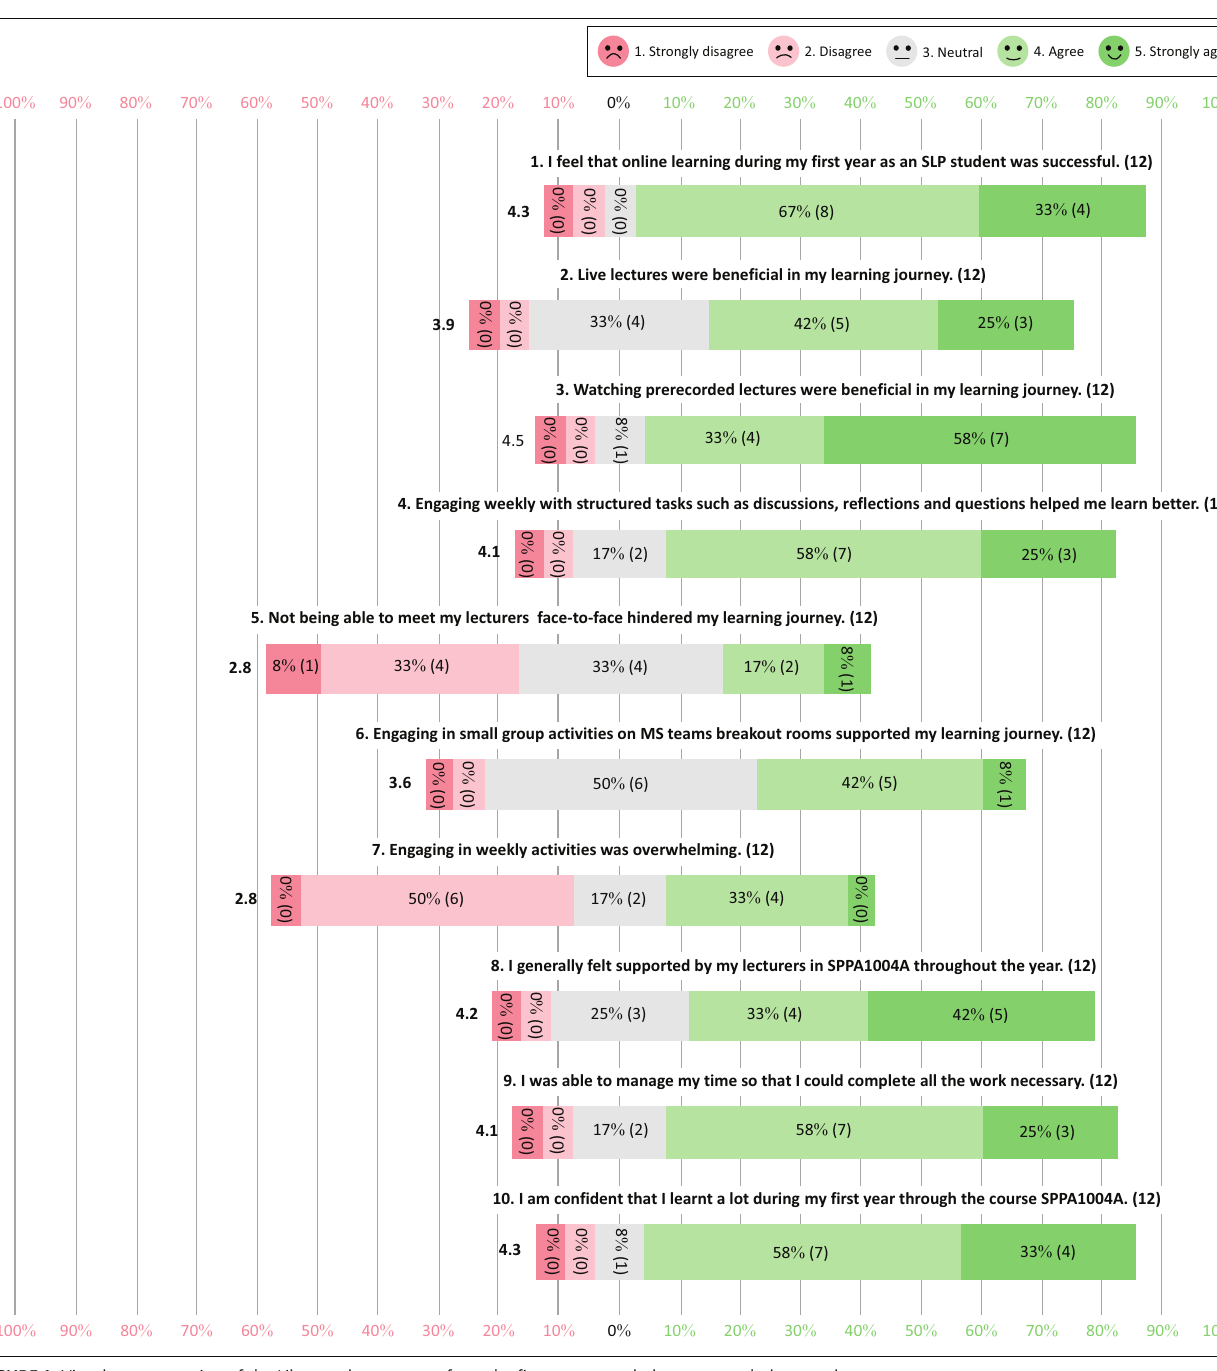
FIGURE 1: Visual representation of the Likert scale responses from the first-year speech–language pathology